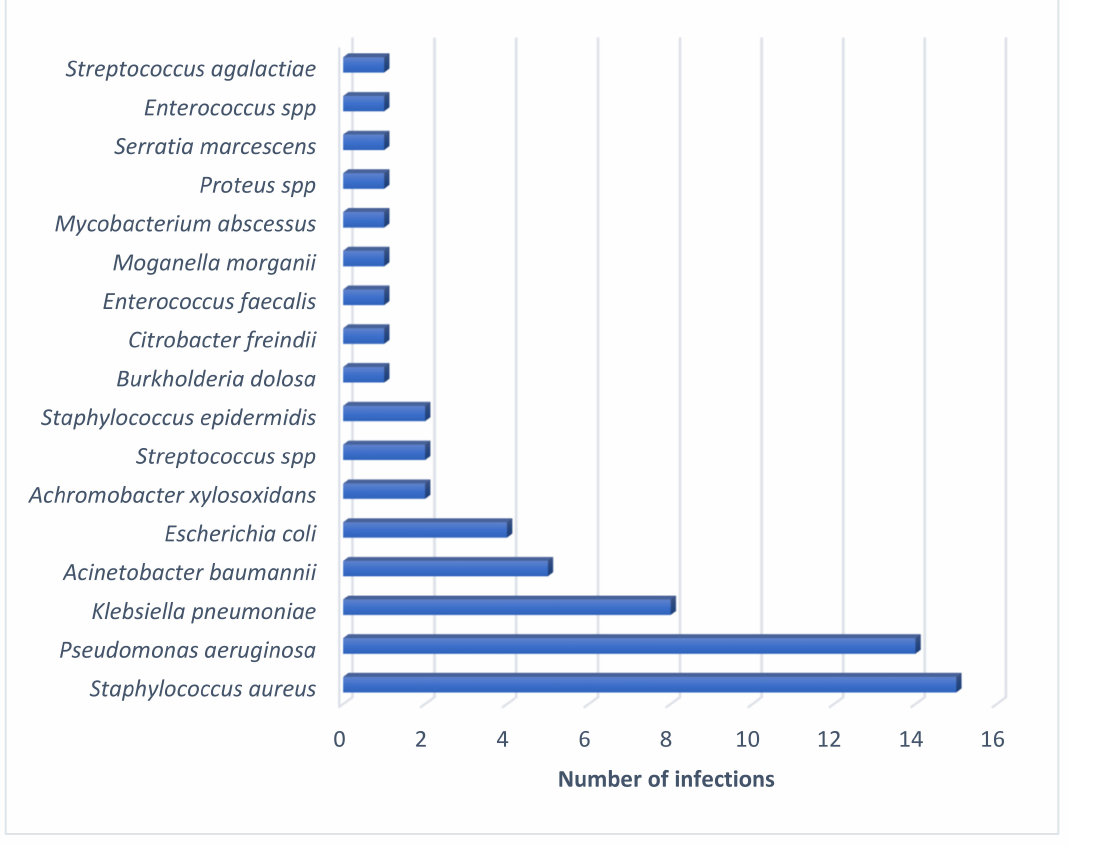
Figure 2. Number of infections caused by each of the multidrug-resistant bacteria mentioned in the